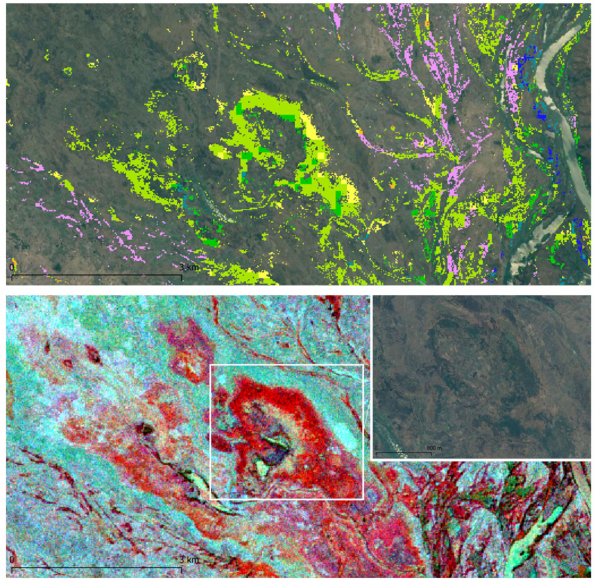
Figure 19. Detail area ( h ) in Figure 10. Top: pixels corresponding to cluster 12, colored according to the underlying CORINE class; background from Google Earth TM imagery. Bottom: same area, extracted from the RGB change image in Figure 12. Inset shows a forest clearing corresponding to the reddish area in the SAR change color